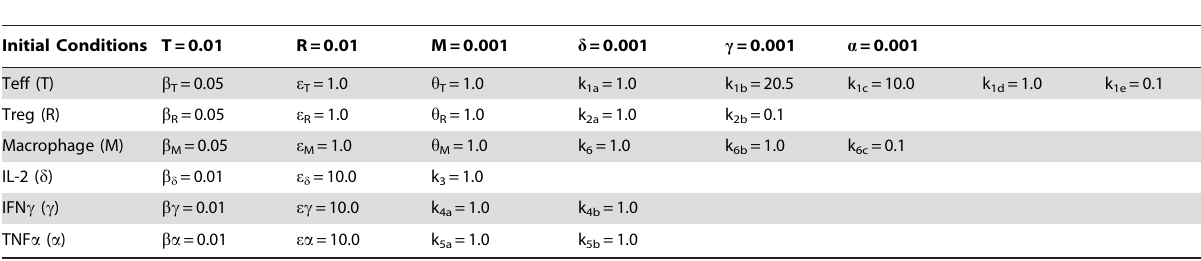
Table 2. Base parameter values used for the detailed model in Fig. 2A (see also Fig. S2).